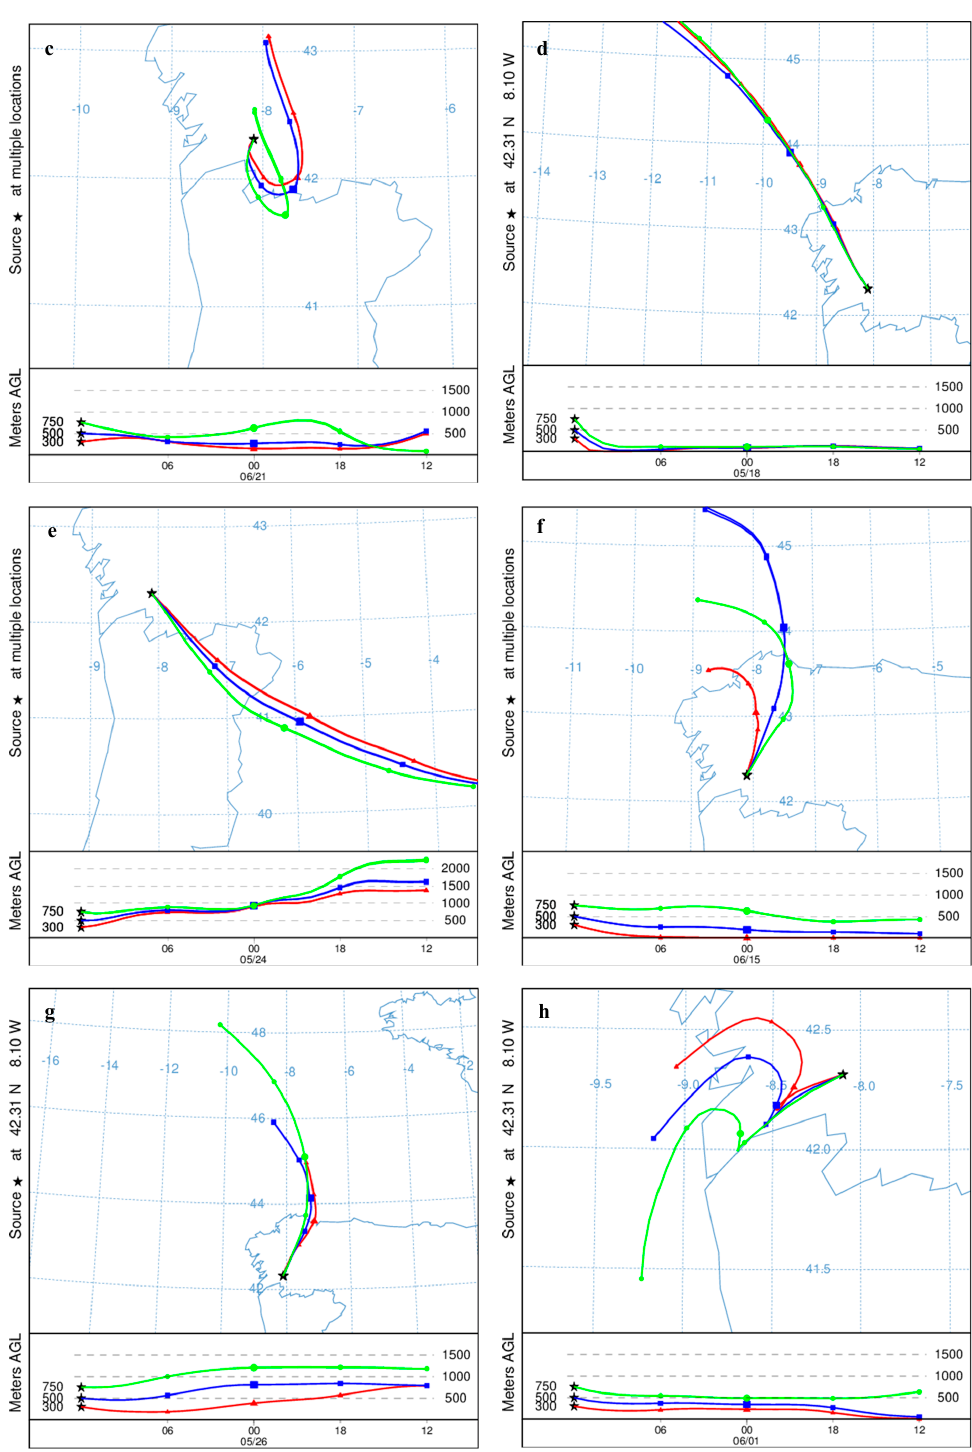
Figure 5. HYSPLIT backward trajectories 24-h at a final height of 300, 500, and 750m agl at considered Vitis vinifera L. pollen peak episodes: ( a ) 29th May 2015; ( b ) 10th June 2016; ( c ) 21th Jun 2016; ( d ) 18th May 2017; ( e ) 24th May 2017; ( f ) 15th Jun 2018; ( g ) 26th May 2019; ( h ) 1st June